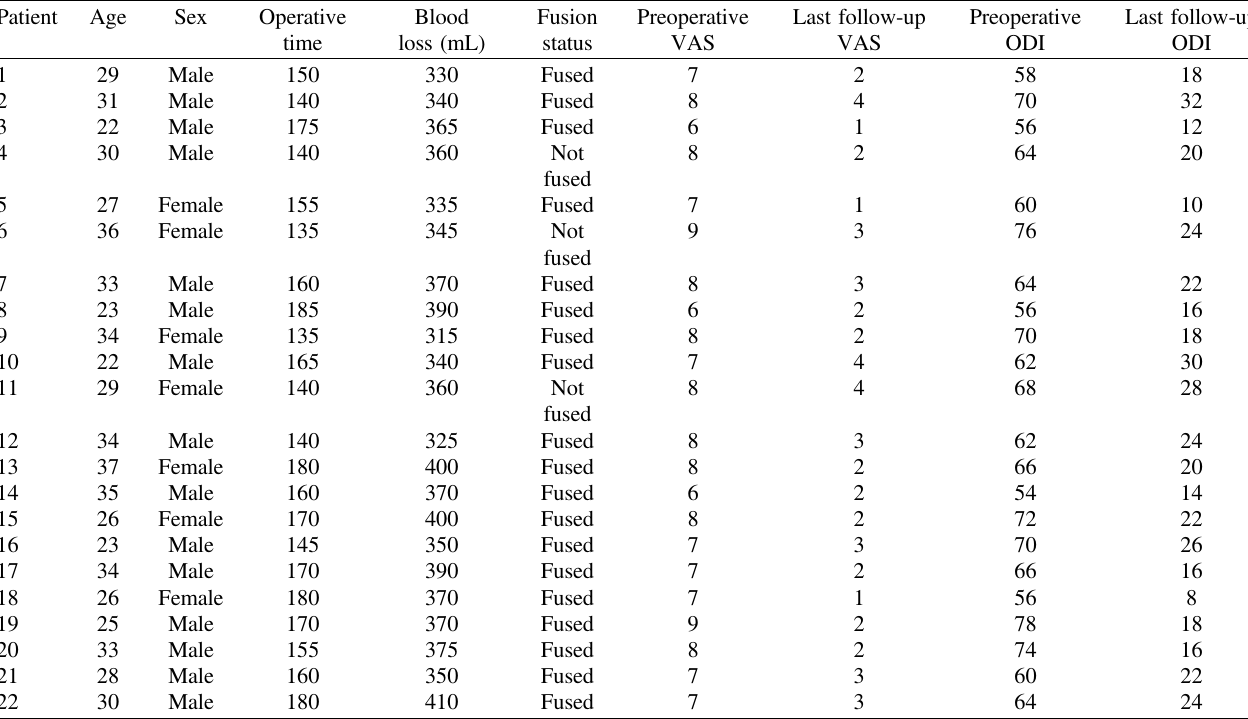
Table 1. Demographic data, operative time, blood loss, fusion status, VAS scoring, ODI scoring